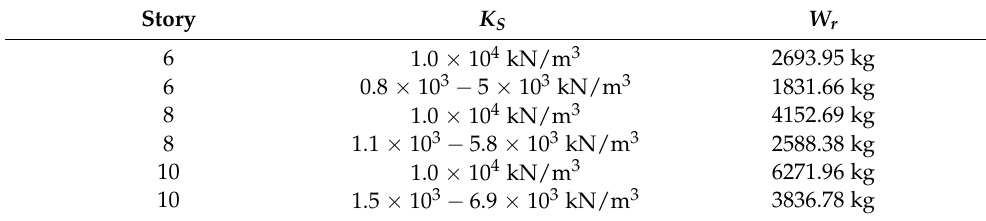
Table 2. The used weight of reinforcement ( Wr ) with constant and variable K S values.